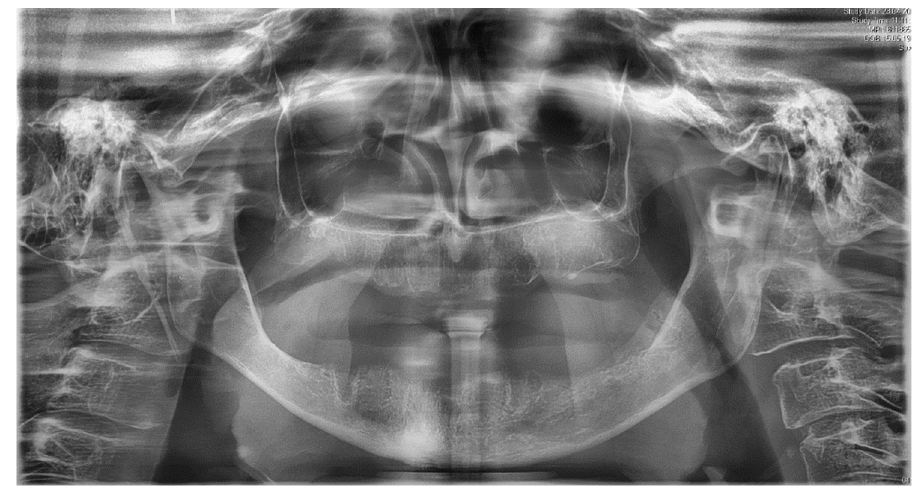
Figure 3. Preoperative panoramic view.